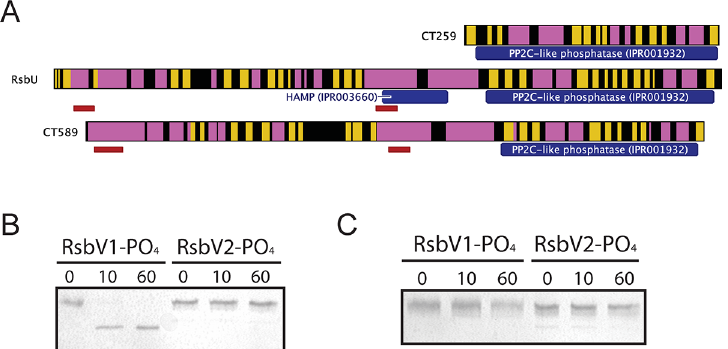
Fig 3. Proteins containing putative PP2C-like phosphatase domains in C . trachomatis . (A) Predicted secondary structure is shown for CT259, RsbU- Ct and CT589 ( β -sheet represented by yellow, α -helix represented by pink). The RsbU Ct and CT589 paralogues are both predicted to transverse the bacterial inner membrane (represented by red bars), whereas no transmembrane domains were predicted for CT259. Phosphatase assays revealed that the RsbU Ct PP2C-like domain was capable of dephosphorylating RsbV1, but not RsbV2 (B). CT259 did not dephosphorylate either antagonist (C). Each panel is representative of two experiments in which the same results were